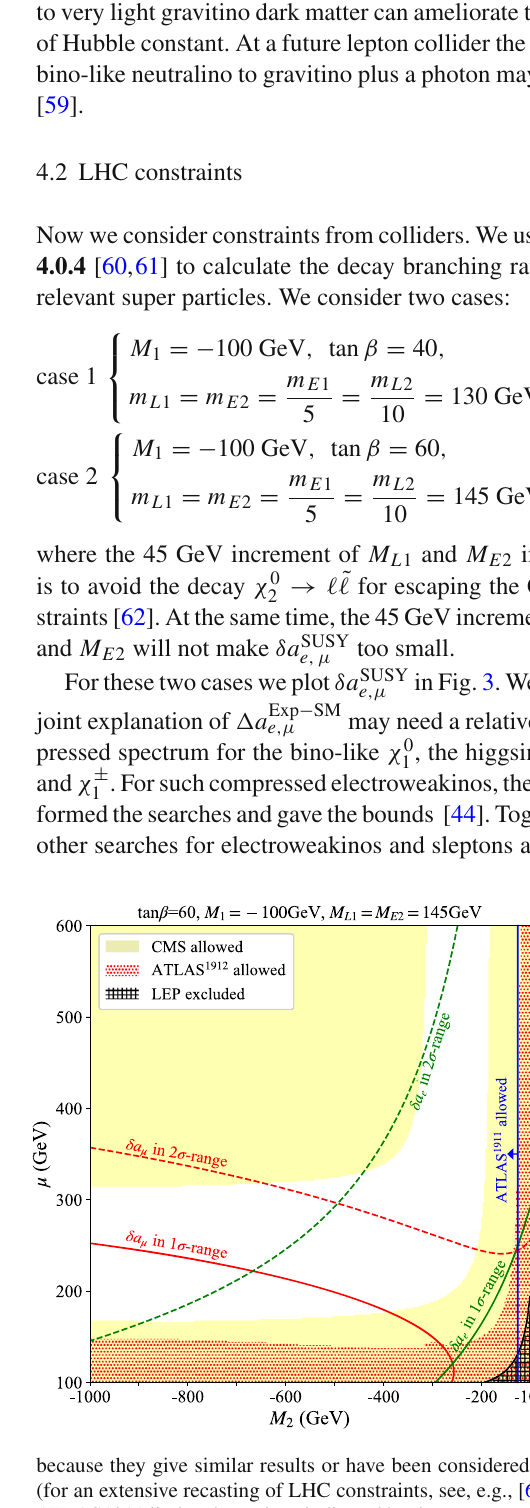
because they give similar results or have been considered in our scan (for an extensive recasting of LHC constraints, see, e.g., [66]). For the ATLAS1911 limits, the regions indicated by the arrows are the allowed